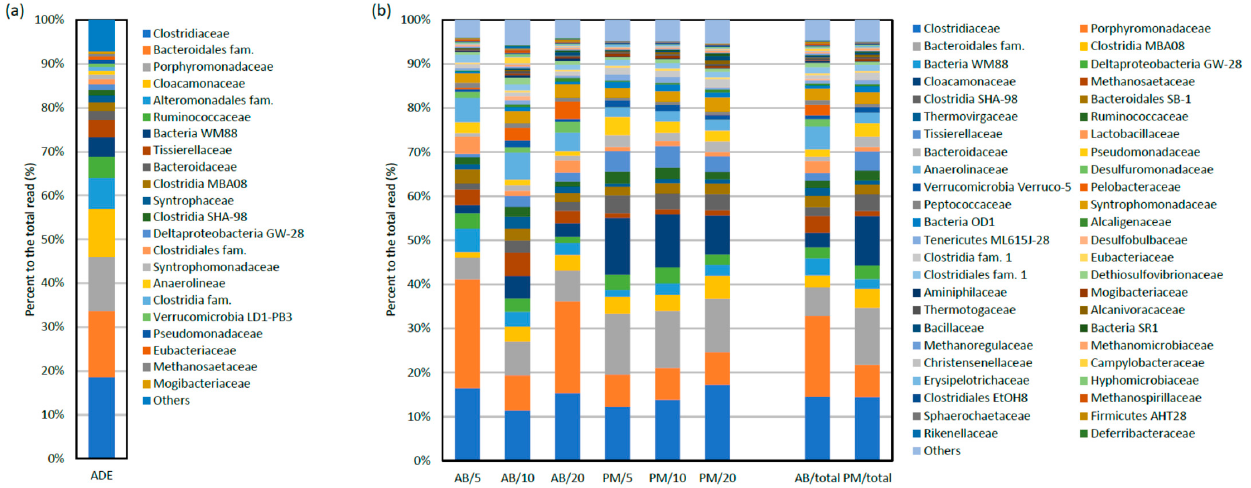
Figure 4. Comparative metabarcoding for bacteria in MFCs operated at different HRTs. ( a ) A metabarcoding profile for ADE obtained from the AD plant. ( b ) Metabarcoding profiles for bacteria in MFCs. Sample names indicate anode biofilms (AB), planktonic microbes (PM) and HRT of MFCs (5, 10 and 20 days). Sums of metabarcoding data for the AB fractions in MFCs at HRTs of 5, 10 and 20 days and those for the PM fractions are presented as AB/total and PM/total, respectively.